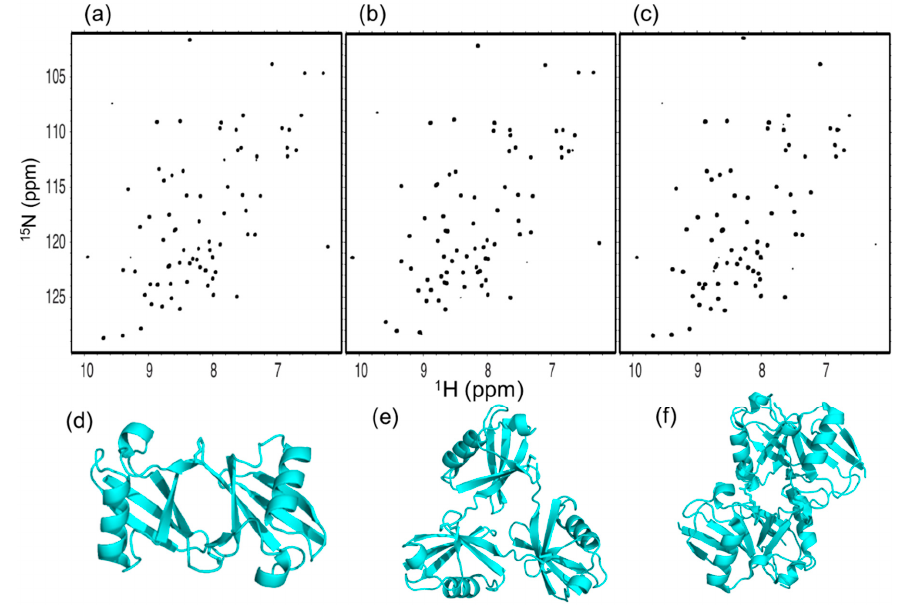
Figure 3. 1 H- 15 N HSQC spectra of uniformly 15 N-labeled ( a ) c-diUb, ( b ) c-triUb, and ( c ) c-tetraUb. 3D structural models of ( d ) c-diUb [20], ( e ) c-triUb (solved in this study, PDB: 7CAP), and ( f ) c-tetraUb (PDB: 3ALB) [27].